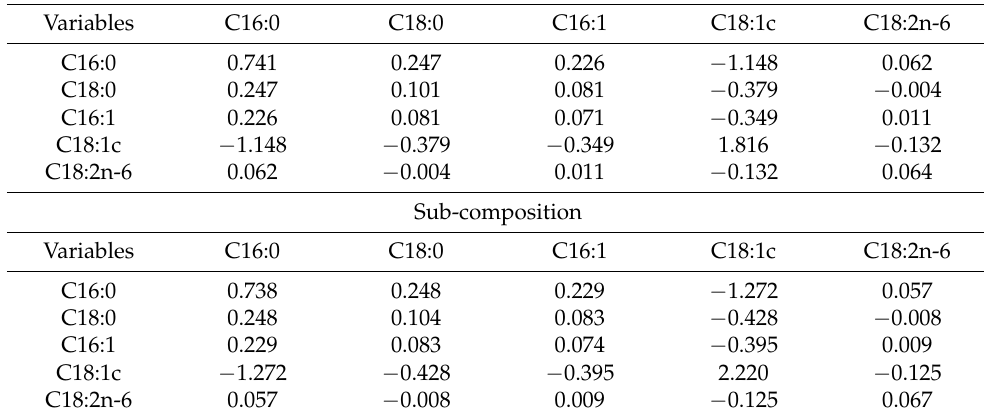
Table 2. Covariance matrix (Pearson) among the complete fatty acid data set of Manzanilla and a sub-composition of it. To simplify, only the values of the whole data set corresponding to the fatty acids involved in the sub-composition are